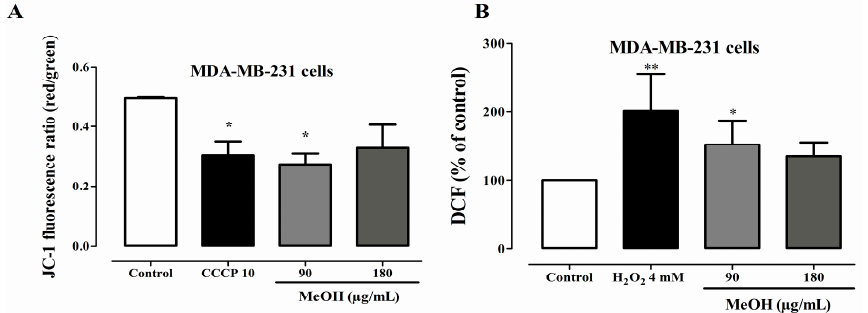
Figure 6. Effects of F. umbellata extract on oxidative stress parameters. Mitochondrial transmembrane potential ( A ); and intracellular reactive oxygen species (ROS) levels ( B ) in MDA-MB-231 cells treated with 90 and 180 μ g/mL of F. umbellata MeOH extract for 24 h. The mitochondrial membrane potential was measured using the JC-1 fluorescent probe, while ROS level was determined using the DCHF-DA fluorescent probe by spectrofluorimeter. * p < 0.05 and ** p < 0.01 as compared to control. For Western blotting, β -actin was used as an internal control.